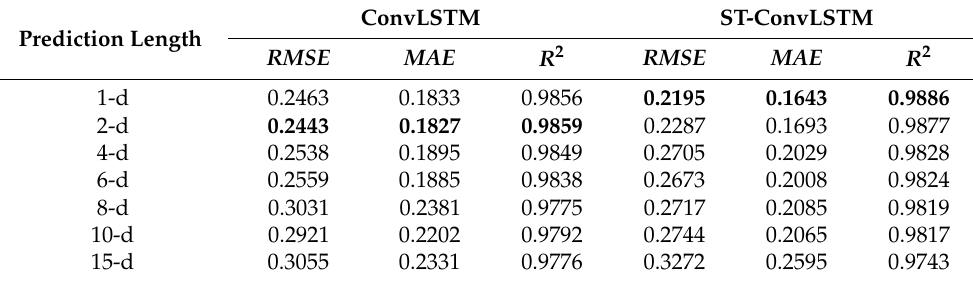
Table 4. Effect of prediction length on SST prediction.